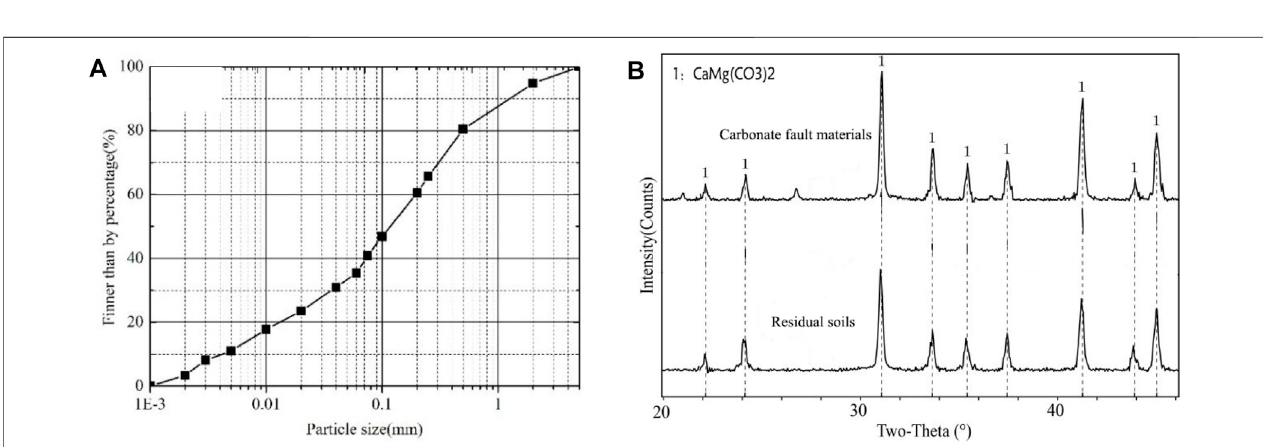
FIGURE 4 | (A) Particle size distributions and (B) the XRD results of carbonate fault materials and residual soils on the sliding surface.